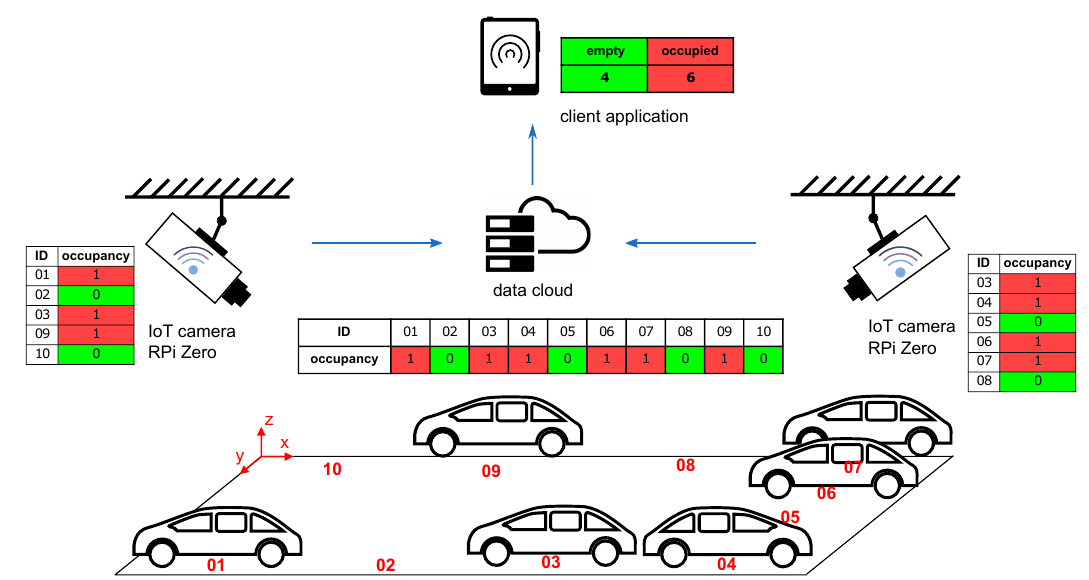
Figure 1. Multicamera parking slot